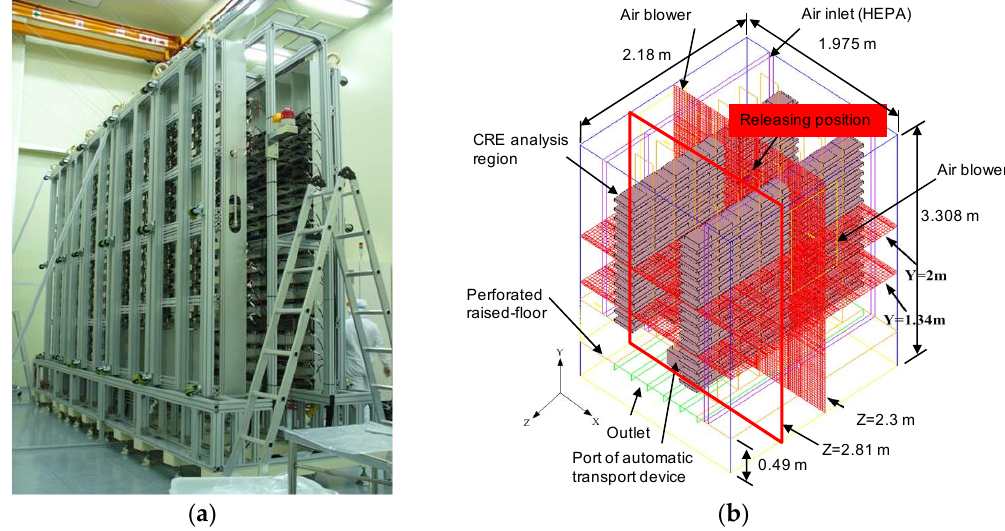
Figure 1. The geometrical configuration of the stocker used in this study: ( a ) a reticle stocker used in a factory and ( b ) the cross-section selected for analysis and particle release positions within a reticle box.